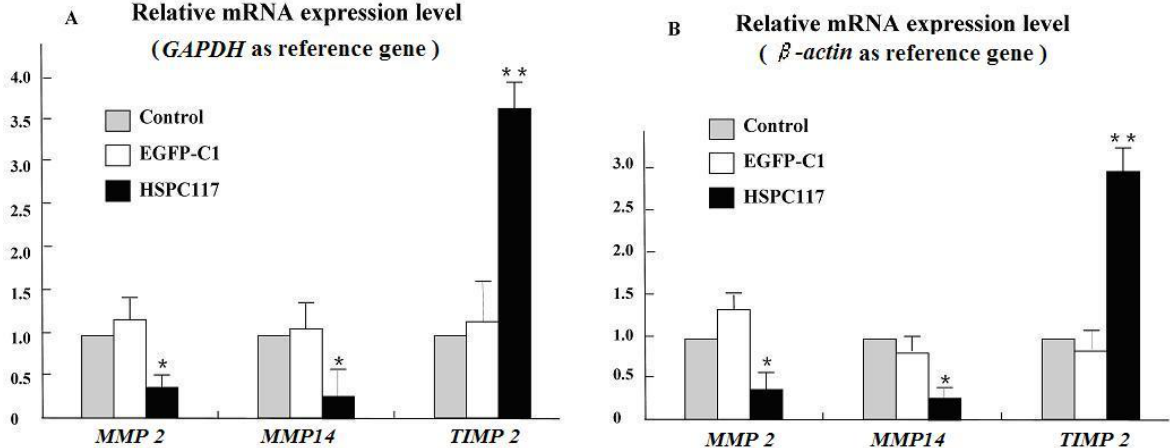
Figure 2. Relative mRNA expression of MMP 2 , MMP 14 , and TIMP 2 in JEG-3 cell